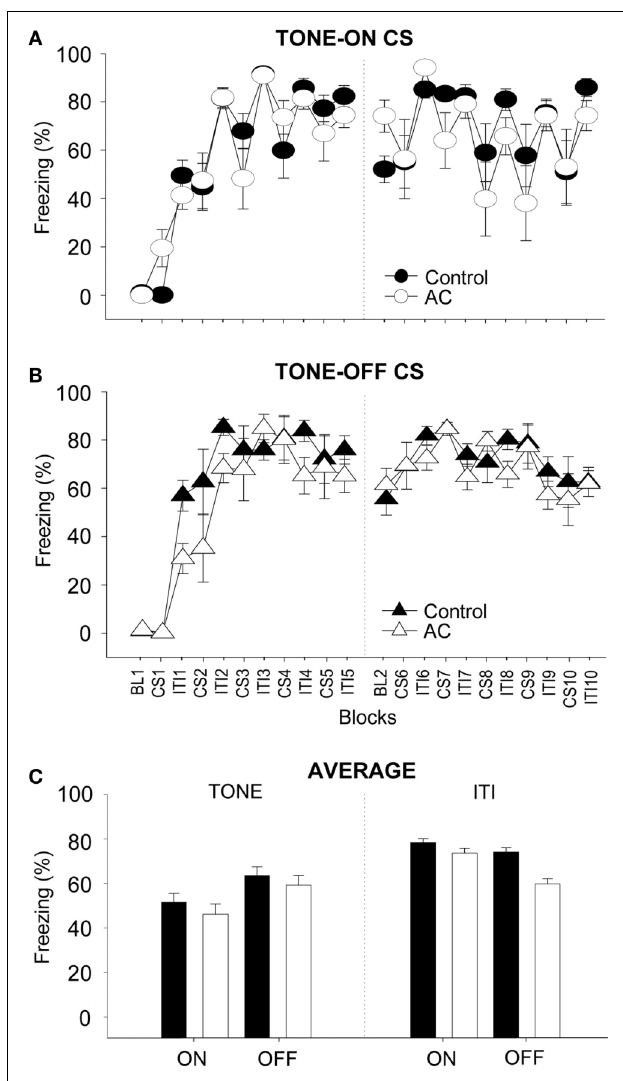
FIGURE 3 | Effects of auditory cortex (AC) lesions on TONE - ON and TONE - OFF fear conditioning. (A,B) Mean ± SE (error bars) percentage of freezing (expressed as blocks) during the 3 min baseline (BL, 10 CS–US pairings (CS), and intervening 3 min inter-trial intervals (ITIs) in context A from sham control ( n = 10 for TONE - ON , n = 10 for TONE - OFF ) and AC-lesioned ( n = 8 for TONE - ON , n = 9 for TONE - OFF ) animals: Day1, left panel; Day 2, right panel. (C) Mean percentage of freezing pooled across the 10 CS and ITI periods during TONE - ON and TONE - OFF fear